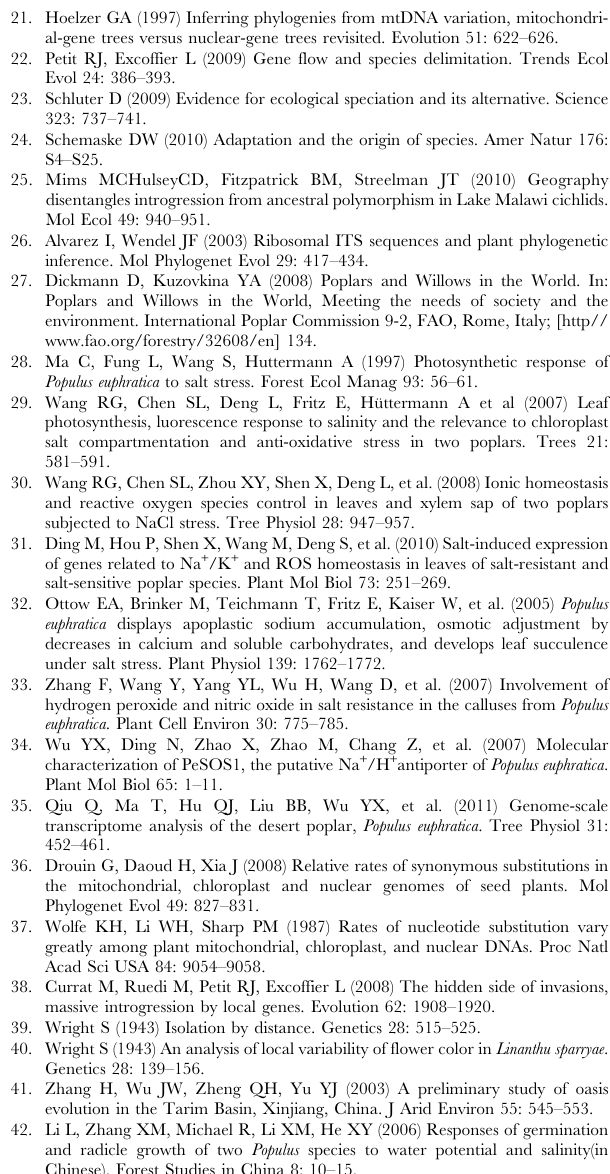
Table S1 List of the sampled individuals for P. eu- phratica and P. pruinosa with their locations and altitudes. (DOC) Table S2 Variable sites of the aligned sequences of two chloroplast DNA fragments in eleven haplotypes of P. euphratica and P. pruinosa ( e , , % indel). Table S3 Three single nucleotide substitutions are distinguished between P. euphratica (Pe) and P. prui- nosa (Pp). Table S4 Estimates were obtained based on eight SSR loci using Analyses of molecular variance (AMOVA).